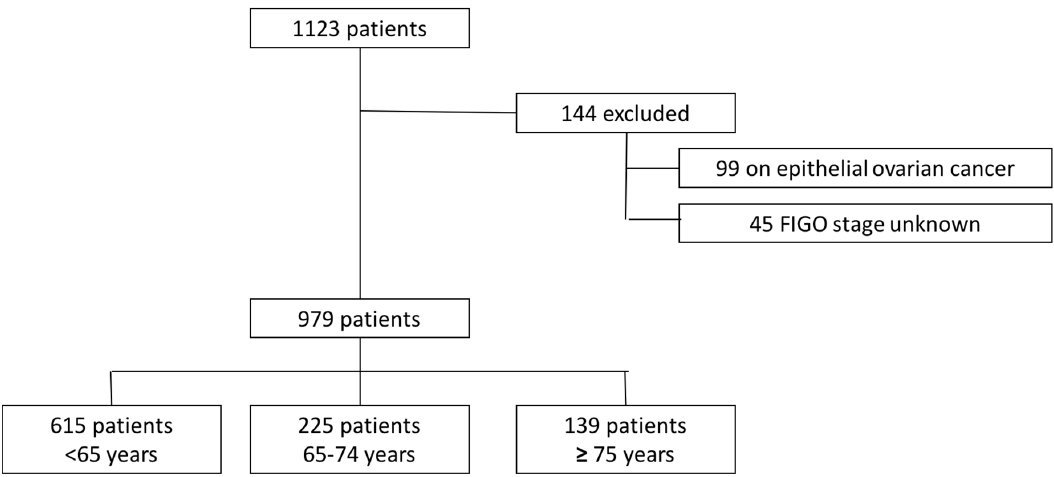
Figure 1. Flow-chart of patient inclusion.